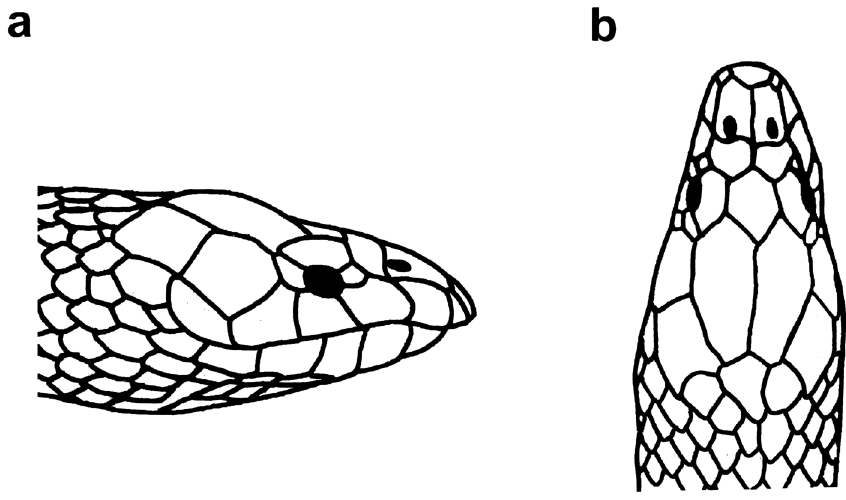
Figure 25. Head of Microcephalophis cantoris : a lateral view b dorsal view.